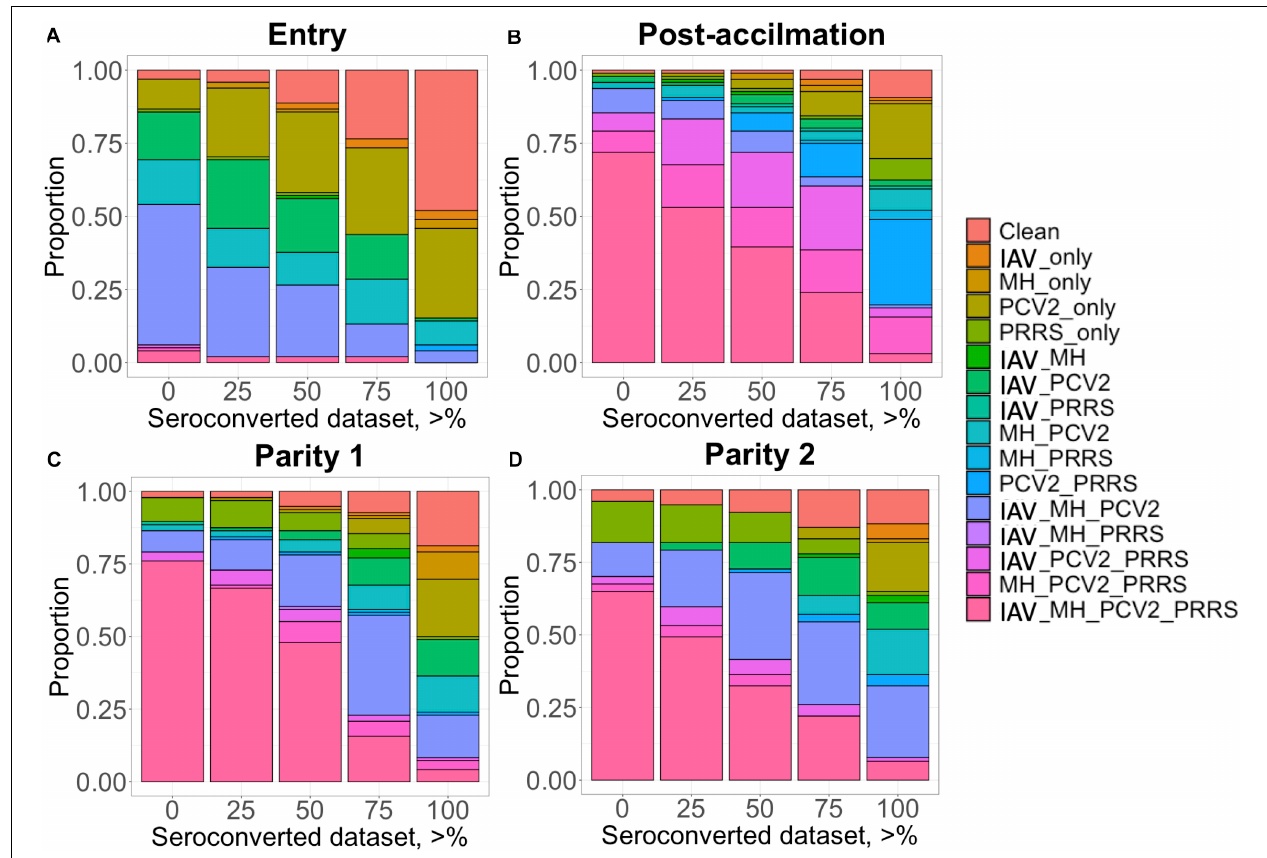
FIGURE 1 | Proportion ( y -axis) of contemporary group (CG) considered seropositive when a minimum percentage of individuals within this CG is positive ( x -axis) for each time point: (A) Entry; (B) post-acclimation; (C) at Parity 1, and (D) at Parity 2. The colors represent the status of the individuals: clean, when free of any infectious diseases; IAV, influenza A virus; MH, Mycoplasma hyopneumoniae; PCV2, porcine circovirus type 2; and PRRS, Porcine Reproductive and Respiratory Syndrome; and all possible combinations of these infectious